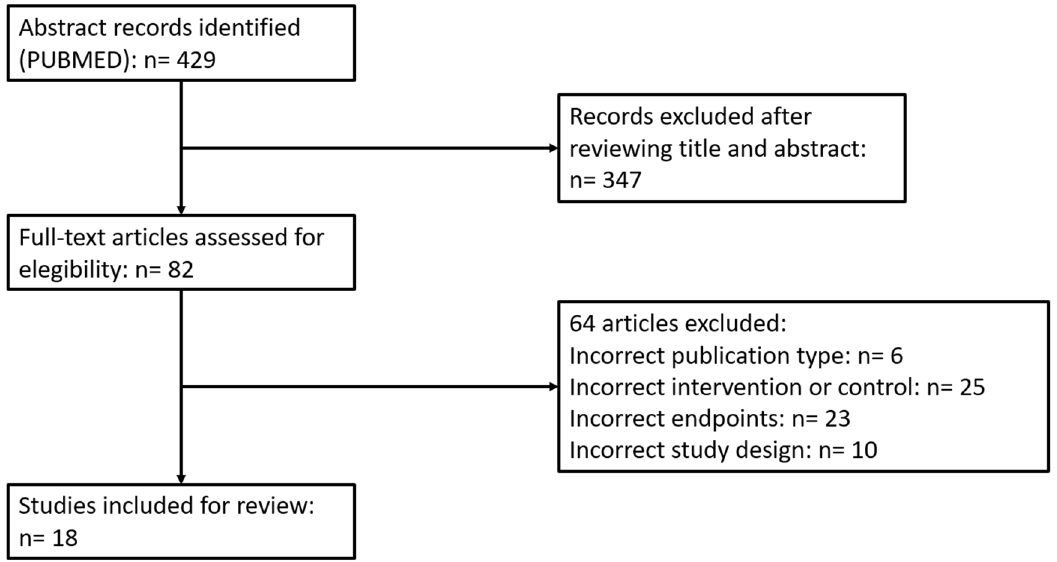
Figure 1. Flow chart of systematic literature search process according to PRISMA statement.